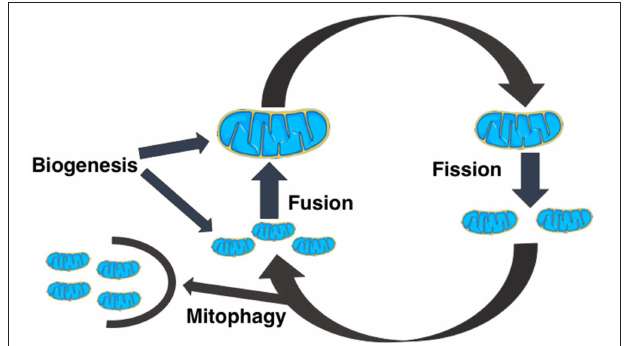
FIGURE 1 | A schematic diagram of the dynamical events that regulate the size, shape, and number of mitochondria in cells. Cells create new mitochondria by the process of biogenesis, a mitochondrion spontaneously divides into two mitochondria by mitochondrial fission, two mitochondria can combine to form a bigger mitochondrion by mitochondrial fusion, and fragmented or unfused mitochondria are removed from the cell by mitophagy.